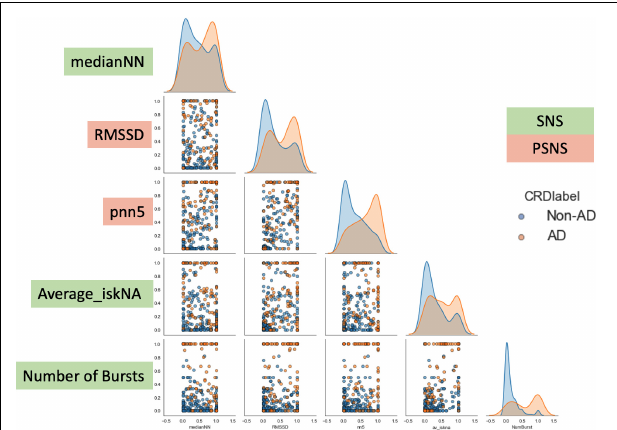
FIGURE 6 | Bivariate plot showing the differences observed in the five features during AD and non-AD events. There is an observed overlap between the two classes but also some differences between the features which make them discernible. The y-axis are the normalized units of each feature. The green boxes are features which represent sympathetic activity while the red boxes are feature which represent vagal activity.